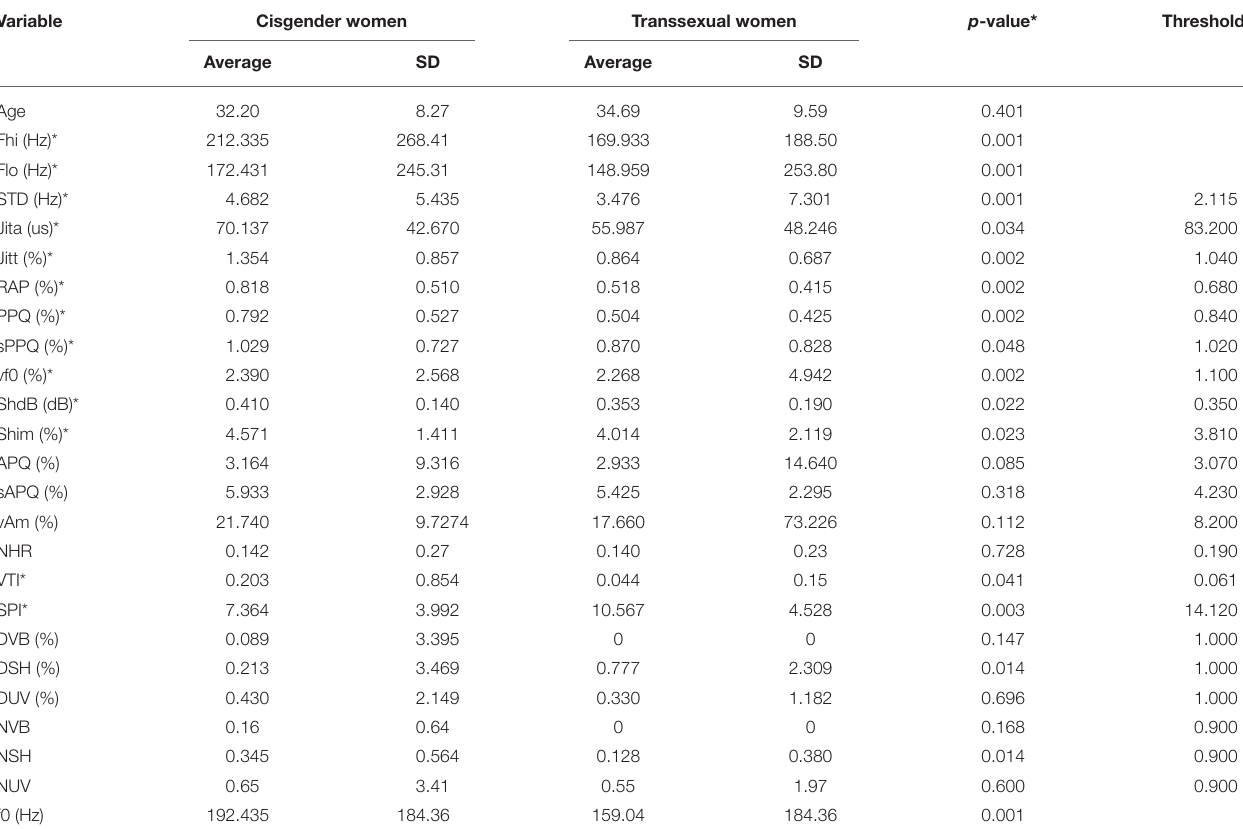
TABLE 1 | Comparisons of numerical variables between cisgender and trans women.